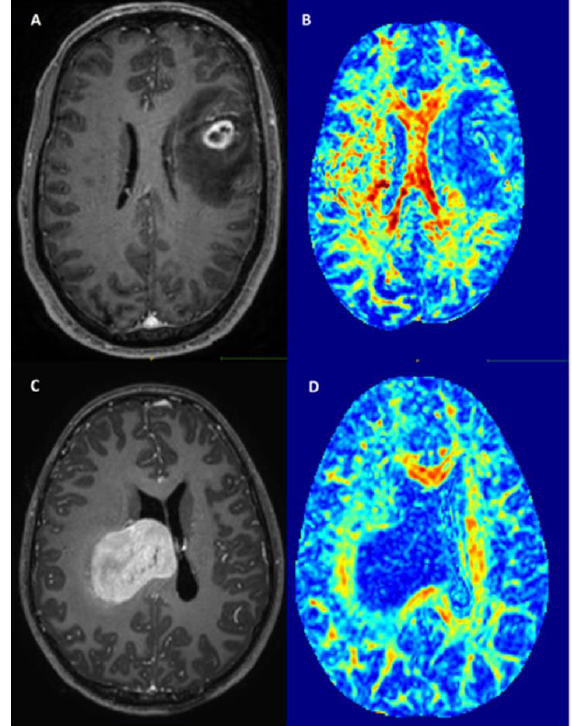
Figure 2. Examples of patients with ( A ) = T1-weighted imaging after contrast agent, ( B) = Fractional anisotropy maps) and without ( C , D ) preoperative seizures.